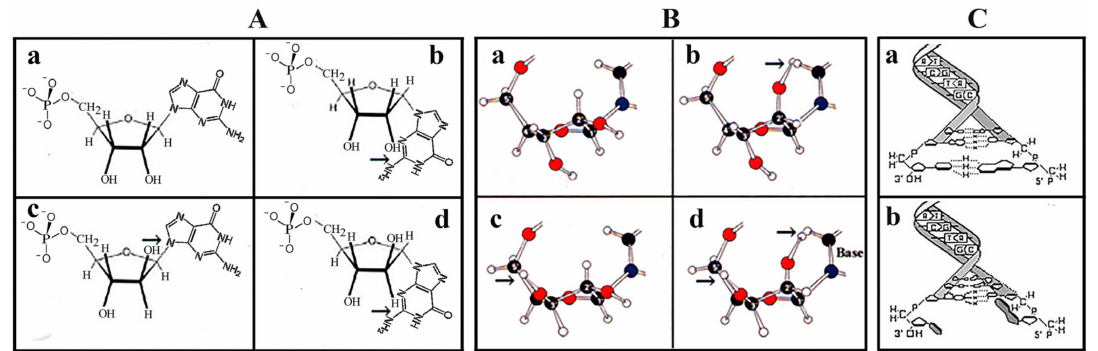
Figure 2. Selection of β - D -ribose as the best fitting pentose in the nucleotide structure. Irrespective of the formose or glyoxylate origin of ribose and the improved production of pentoses did not answer the question of why pentoses, particularly ribose, were selected as the exclusive sugar component of the genetic material. Molecular modeling revealed that free rotation of functional groups (OH, phosphate, nucleobase) of ribose inside nucleotides takes place only in β - D -ribose. ( A / a ), confirmed in ( B / a ). The free rotation of functional groups of the beta anomer of arabinose is hindered by its 2-OH moiety ( A / c ). As far as the alpha anomers of pentoses are concerned, the bulky bases are too close to the sugar and would not allow its free rotation ( A / b , d ). ( B ) confirms that free rotation of the substituents is permitted only in β - D -ribose ( B / a ) but not in arabinose, xylose, or lyxose ( B / b , c , d ). The free movement of functional groups of ribose turned out to be essential to provide maximal flexibility of RNA and to secure the stability and base pairing of deoxyribose in double-stranded DNA ( C ). Double helix formation is possible only in β - D -deoxyribonucleotides ( C / a ) but not between the α - D -deoxyribonucleotide pairs where the nucleobases are not perpendicular to the axis of the helix and will prevent hydrogen bonding between bases ( C / b ). With permission